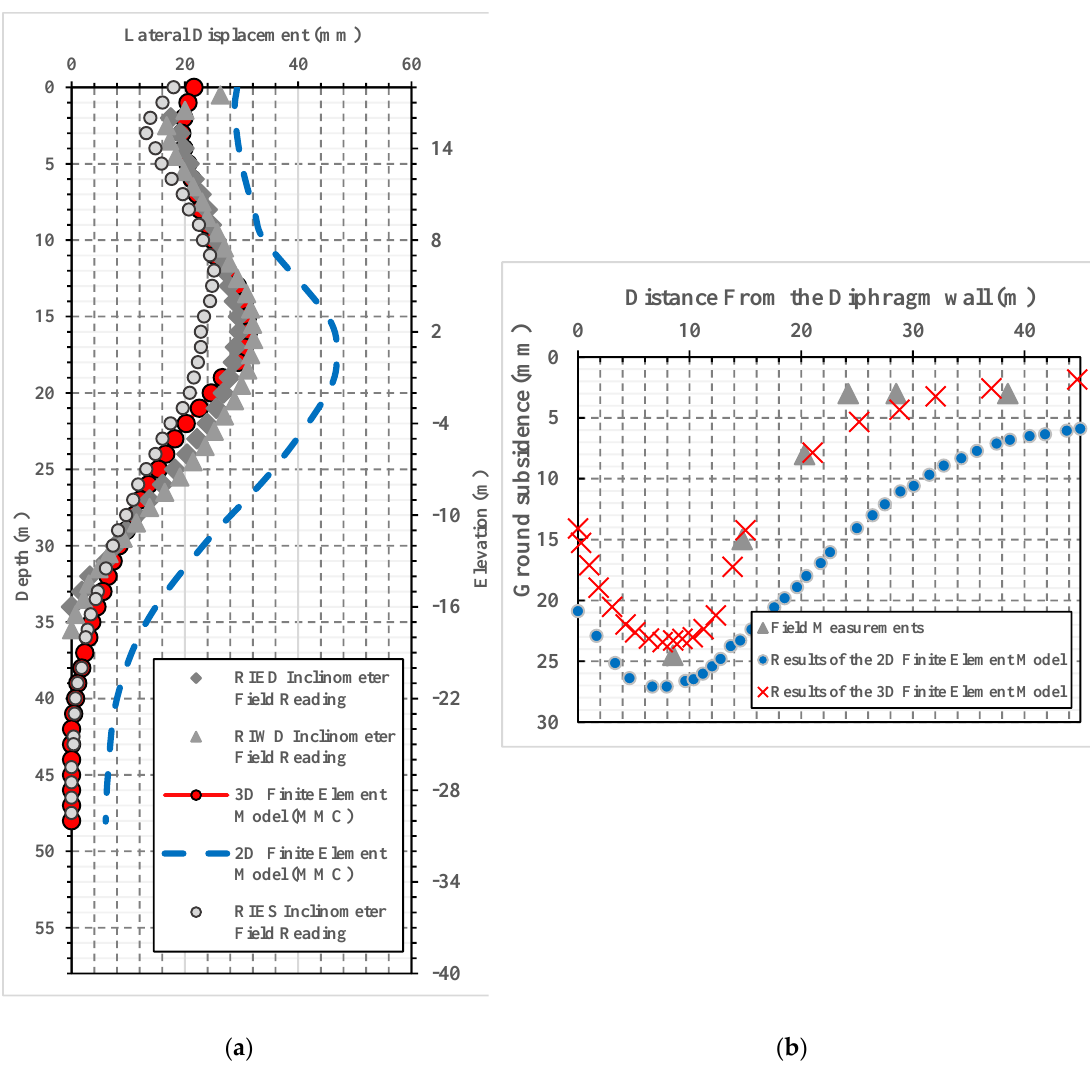
Figure 12. Comparison between field measurements and the obtained numerical results. ( a ) Results of lateral wall deformation. ( b ) Results of vertical ground settlement.